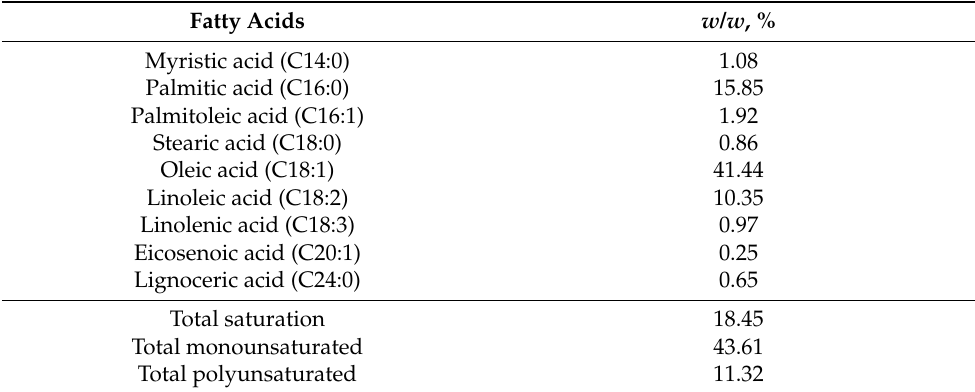
Table 2. Fatty acid profile of single-cell oil from R. mucilaginosa